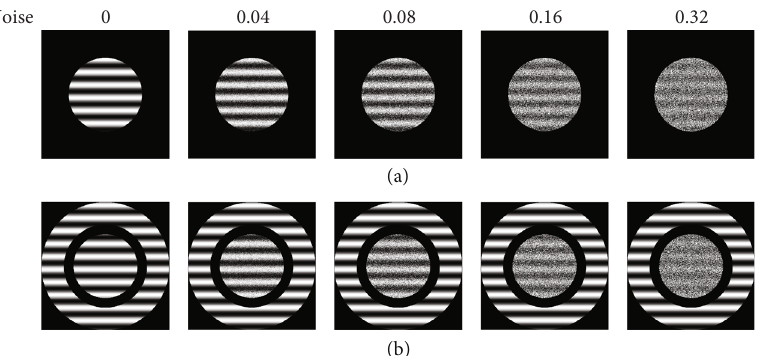
Figure 2: Showing circular patch grating stimuli with di ff erent external noise levels (0, 0.04, 0.08, 0.16, and 0.32) presented only in the cRF (a) as well as noisy circular patch grating stimuli plus annular grating stimuli presented in the sRF (b). The circular grating stimuli and the annular grating stimuli had the same orientation, motion direction, spatial, and temporal frequency as the neuron ’ s preferred parameters. The diameter of circular grating stimuli was equal to the neuron ’ s cRF. The outer diameter of annular grating stimuli was set as large as our display size, and the inner diameter was set equal to the size corresponding to the asymptotic response on the annular size-response tuning curve. The contrast of circular grating stimuli varied between 0% and 100%, and the contrast of annular grating stimuli was fi xed at